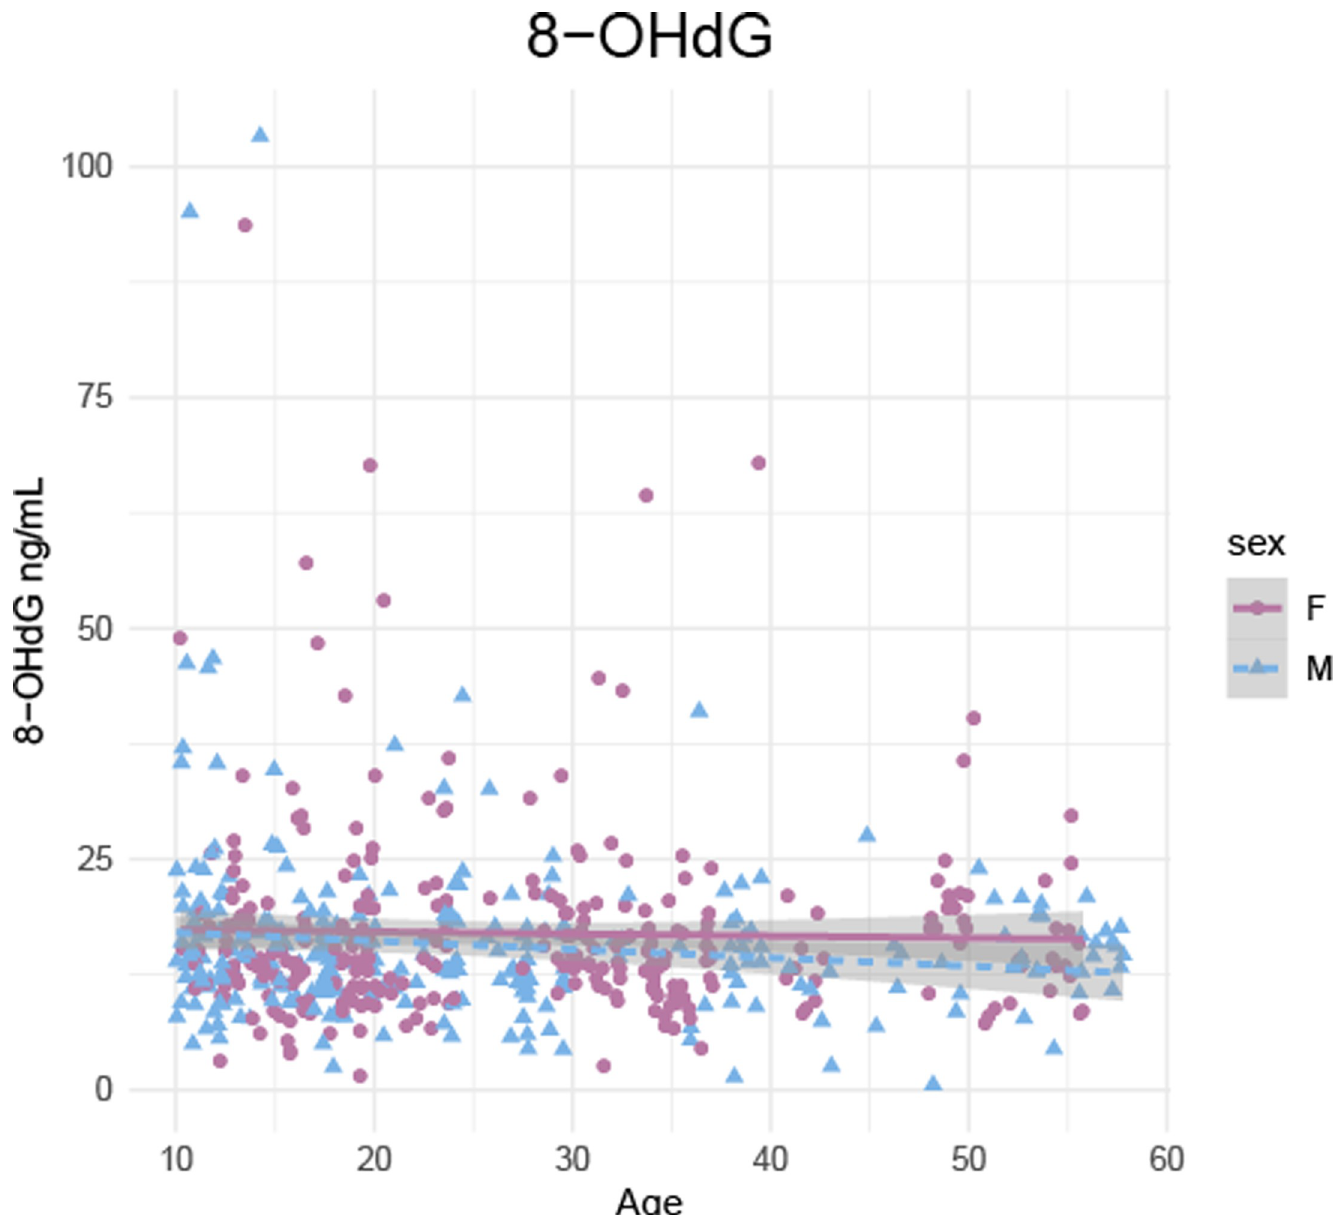
Fig 4. Decrease in 8-OHdG with age in a mixed-longitudinal sample (n = 36 individuals, 583 samples).